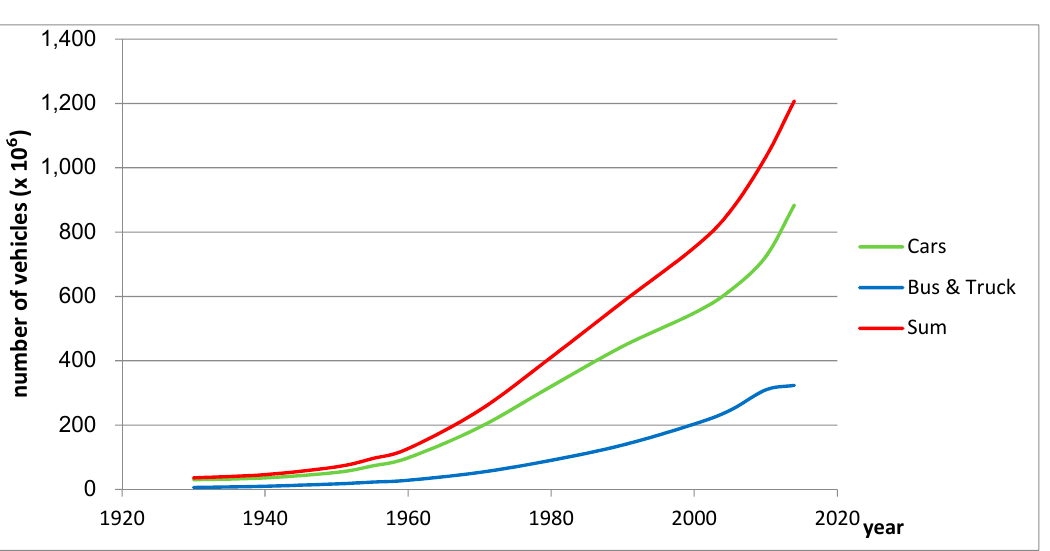
Figure 2. Historic increase of the global number of cars and busses and trucks [59–61].